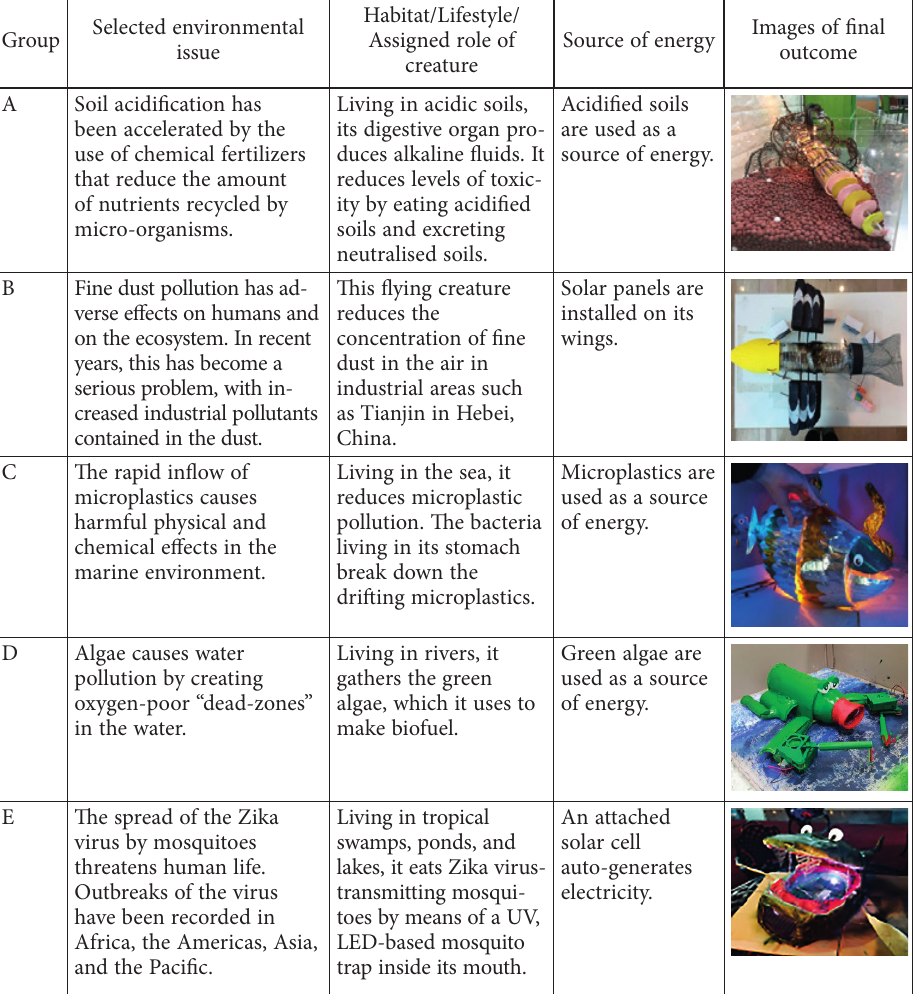
E Th e spread of the Zika virus by mosquitoes threatens human life. Outbreaks of the virus have been recorded in Africa, the Americas, Asia, and the Pacifi c.